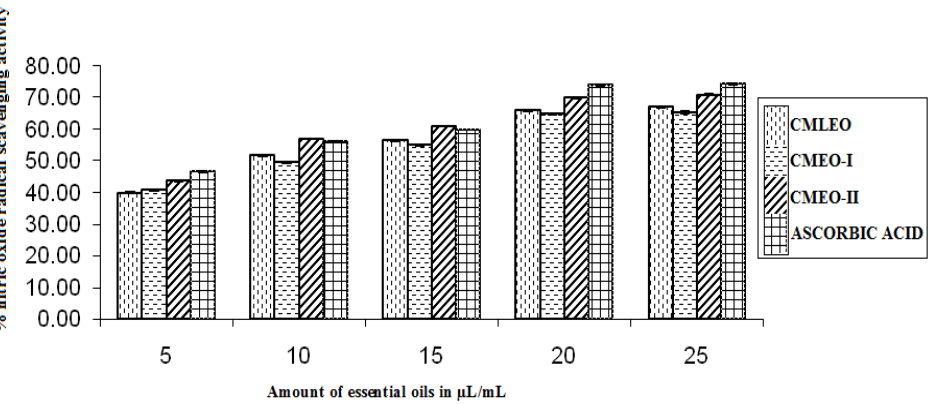
Figure 5. Nitric oxide radical scavenging activity.